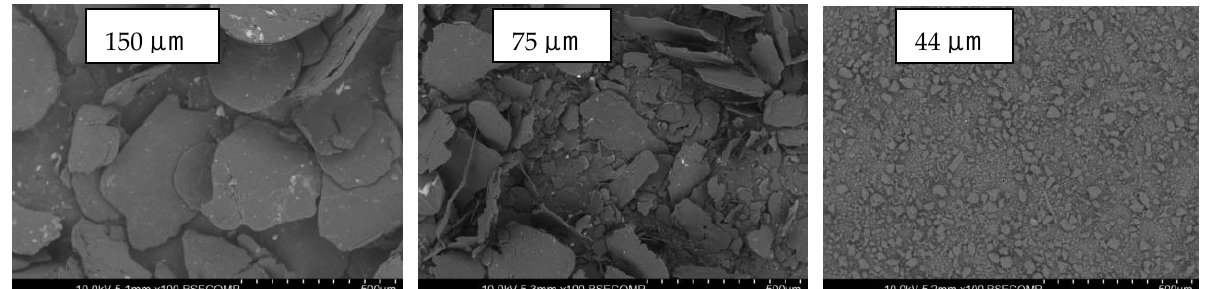
Figure 1. Graphite powders with different particle sizes.